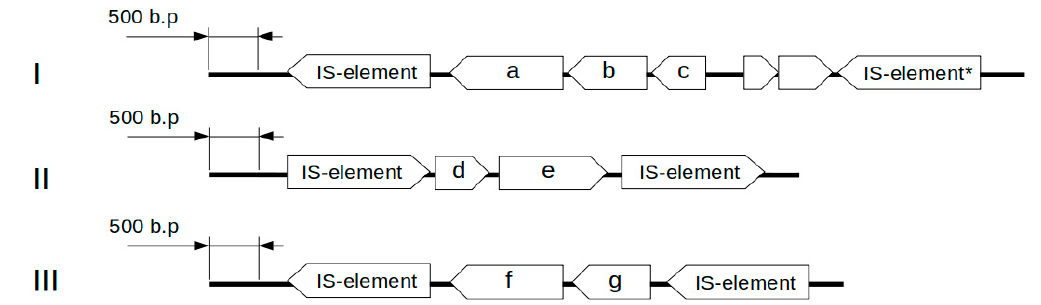
Figure 3. Clusters of genes related to the synthesis of the bacteriocin helveticin J in L. helveticus D75 and D76. ( I ) The genetic cluster consisting of slpA1 (a), helJ1 (b), and helJ2 (c). ( II ) The genetic cluster consisting of helJ3 (d) and slpA2 (e). ( III ) The genetic cluster consisting of slpA4 (f) and helJ5 (g). Asterisks (*) present pseudogenes.